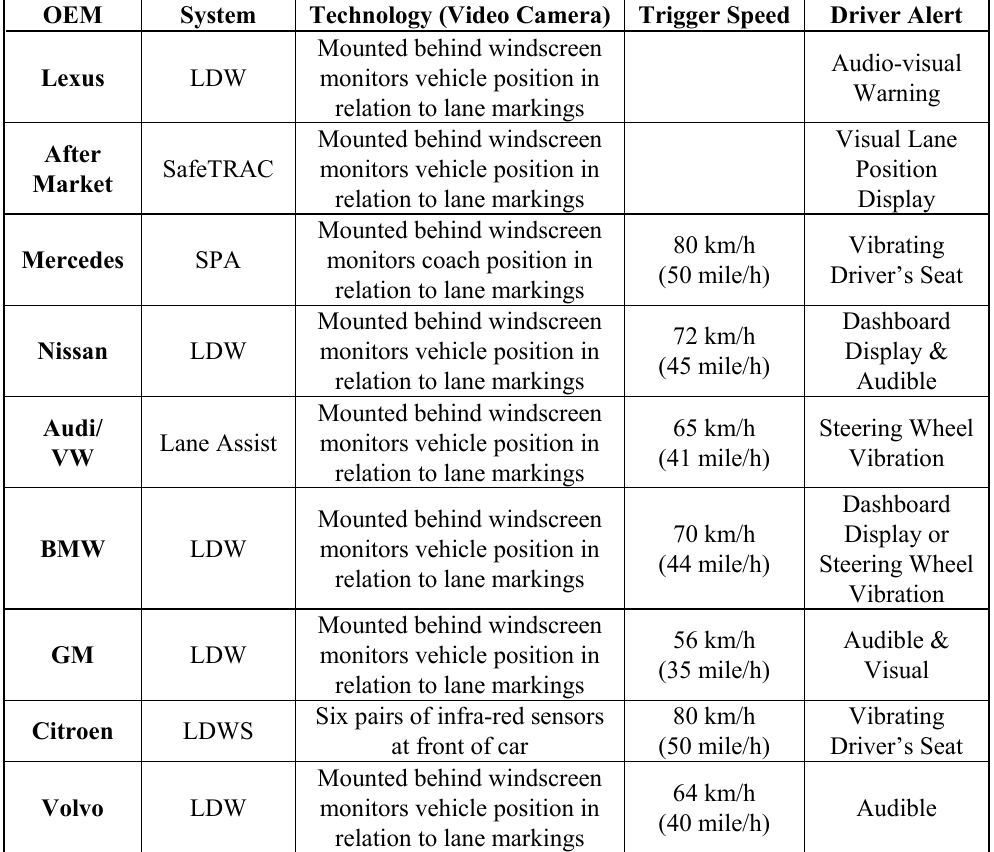
Table 2. Lane departure systems available on